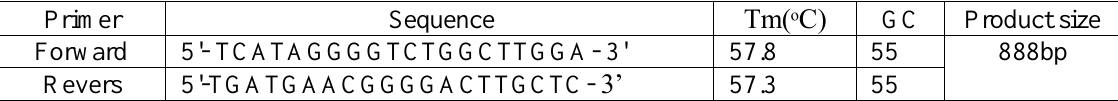
Table 1: The TCF7L2 gene-specific primers sequence.